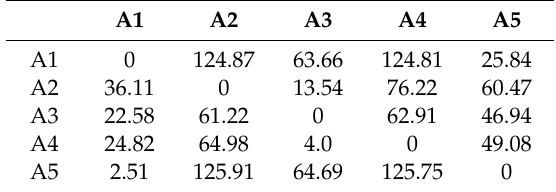
Table 1. The mean first-passage times (MFPTs) between the intermediate states of apo-HFABP (unit: µ s).